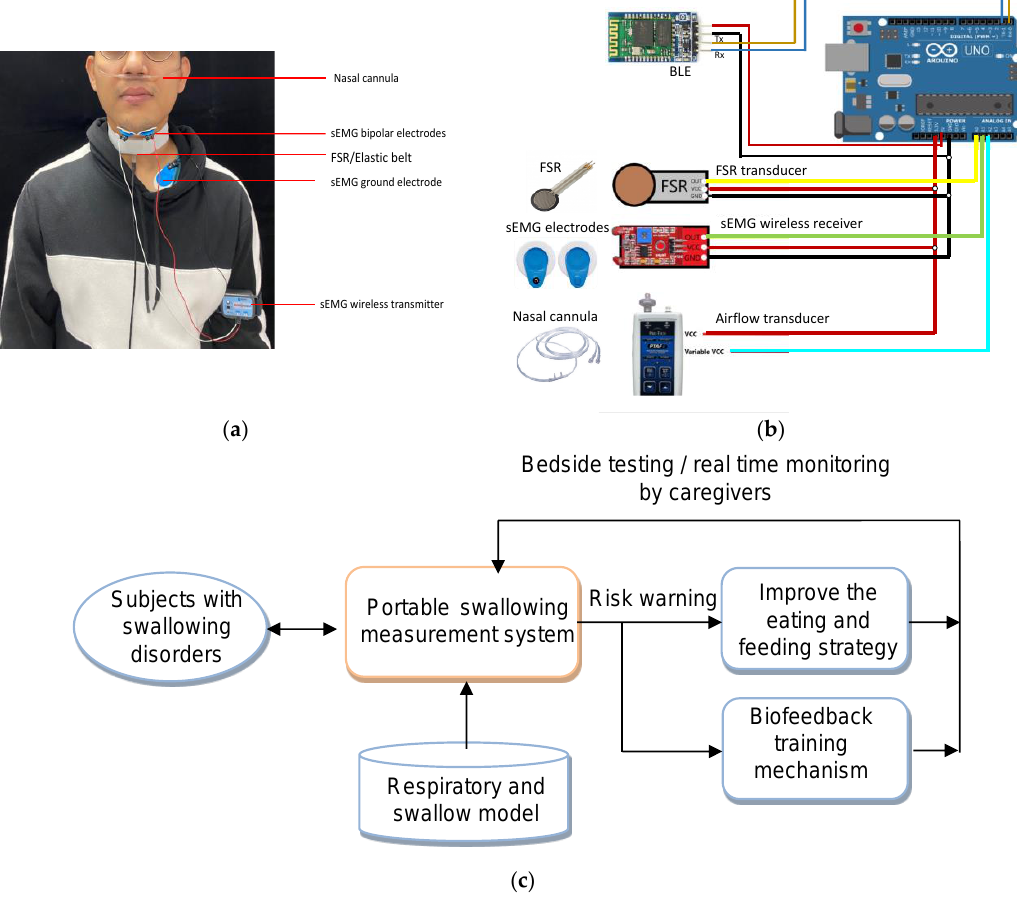
Figure 1. ( a ) Positions of each sensor: sEMG, nasal airflow, and FSR; ( b ) the circuit of the designed signal collector; ( c ) the real-time respiratory – swallowing telecare model.